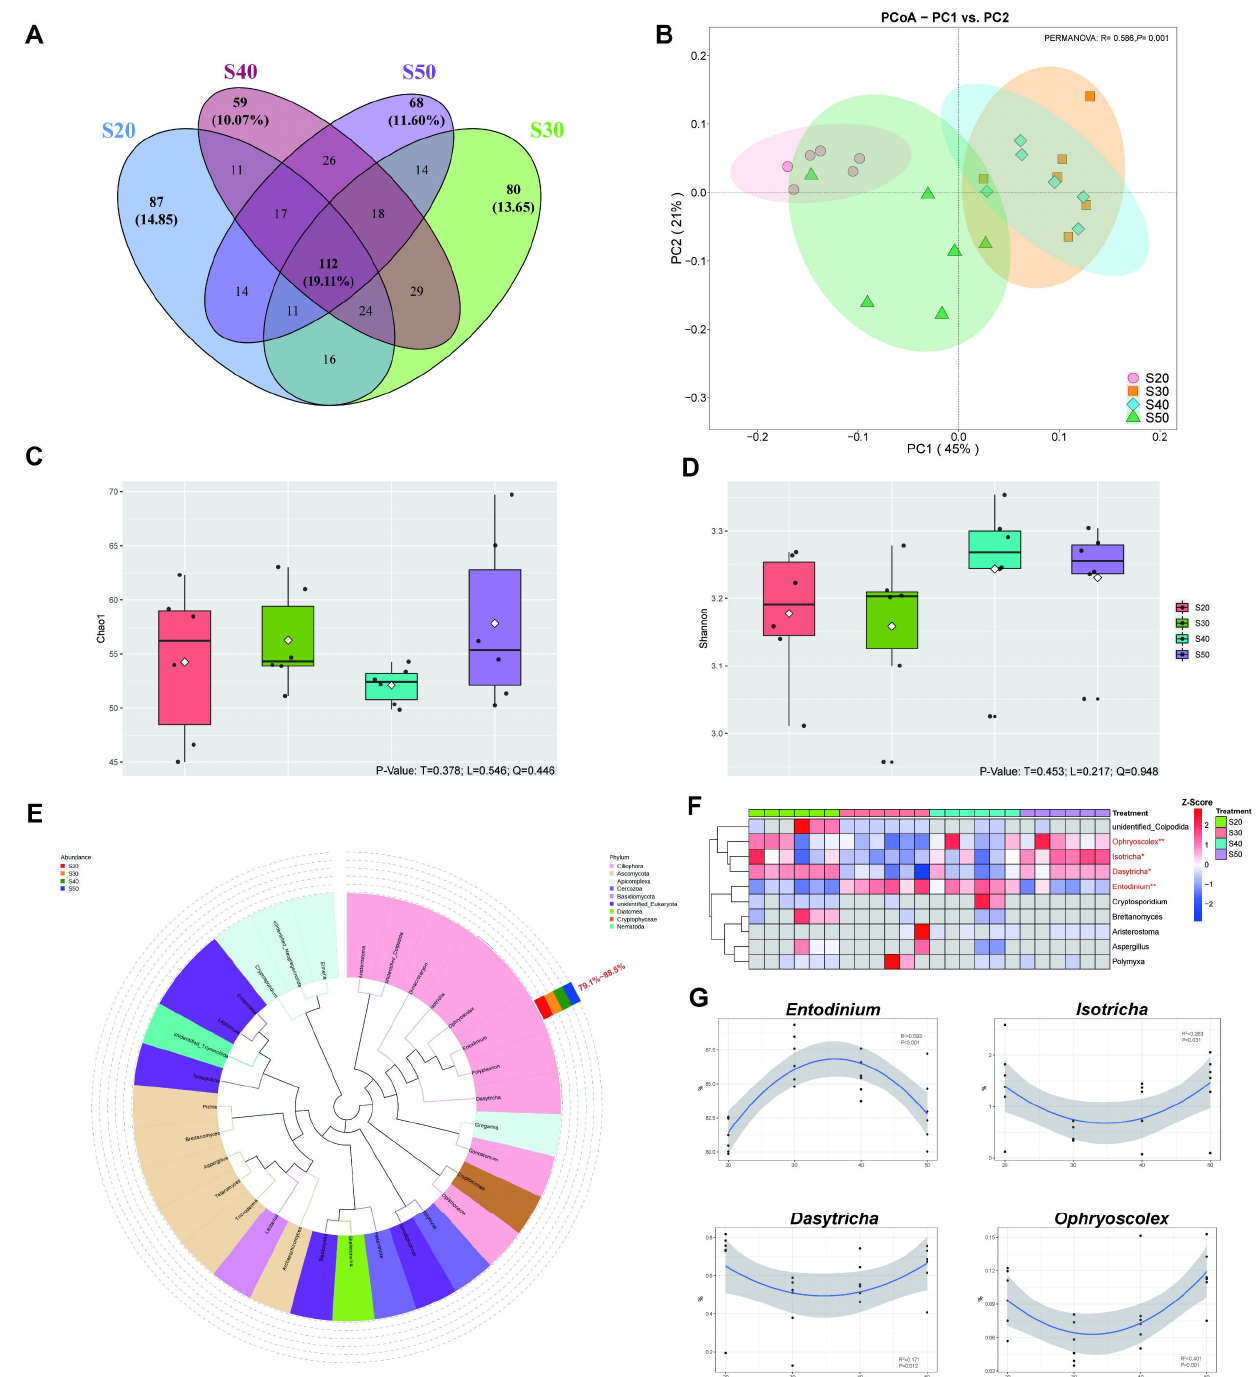
Figure 4. Protozoa composition diversity, taxonomic differences and changing tendency (n = 6). ( A ) Venn diagram showing shared and unique protozoal OTU numbers of four SP treatments. ( B ) Principal coordinate analysis (PCoA) of protozoa based on Bray–Curtis dissimilarity matrix of four SP treatments. ( C, D ) Alpha diversity of protozoa in four SP treatments. ( E ) Protozoa genus evolutionary tree, different colors represent the classification phylum level. ( F ) Heatmap of the top ‐ 10 protozoa genera in relative abundance, * represents p < 0.05 and ** represents p < 0.01. ( G ) The trend of differential protozoa changing with SP. Treatments: S20, S30, S40 and S50 are ~14% CP, SP proportion (% of CP) 20, 30, 40 and 50, respectively.